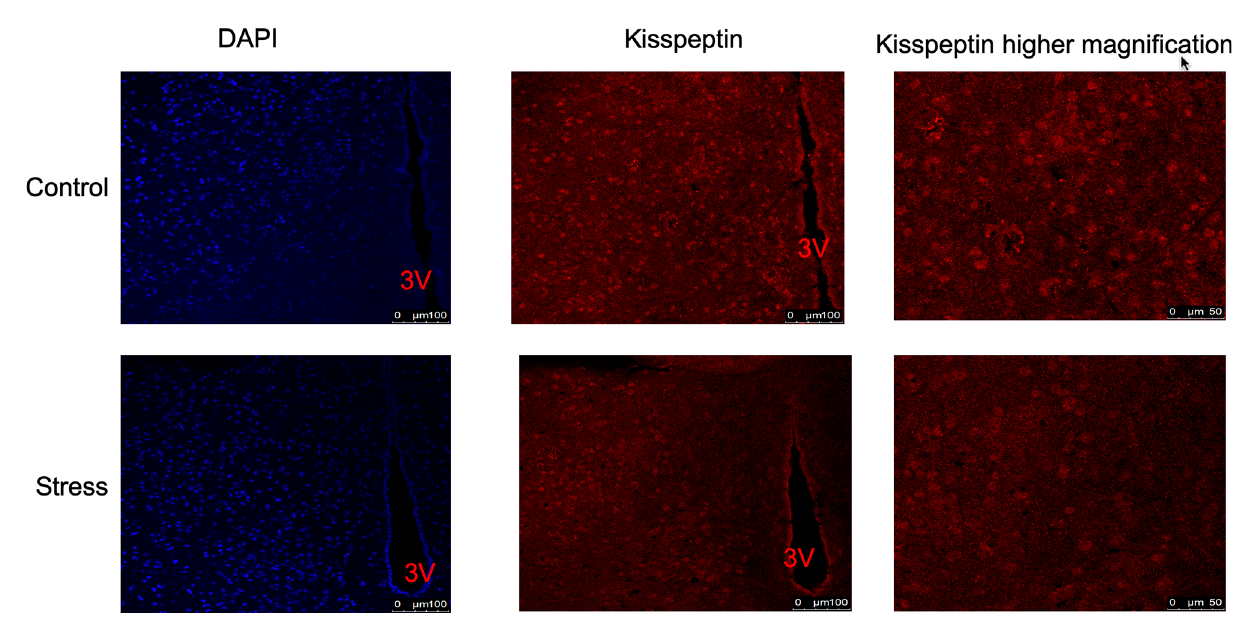
FIGURE 6 | The effect of chronic restraint stress on the expression of Kisspeptin protein in the hypothalamus. The expression of Kisspeptin was detected by immuno fl uorescence. Blue represents DAPI nuclear staining, and red represents Kisspeptin immuno fl uorescence staining. control: control group, stress: restraint stress group. 3V, Third ventricle.